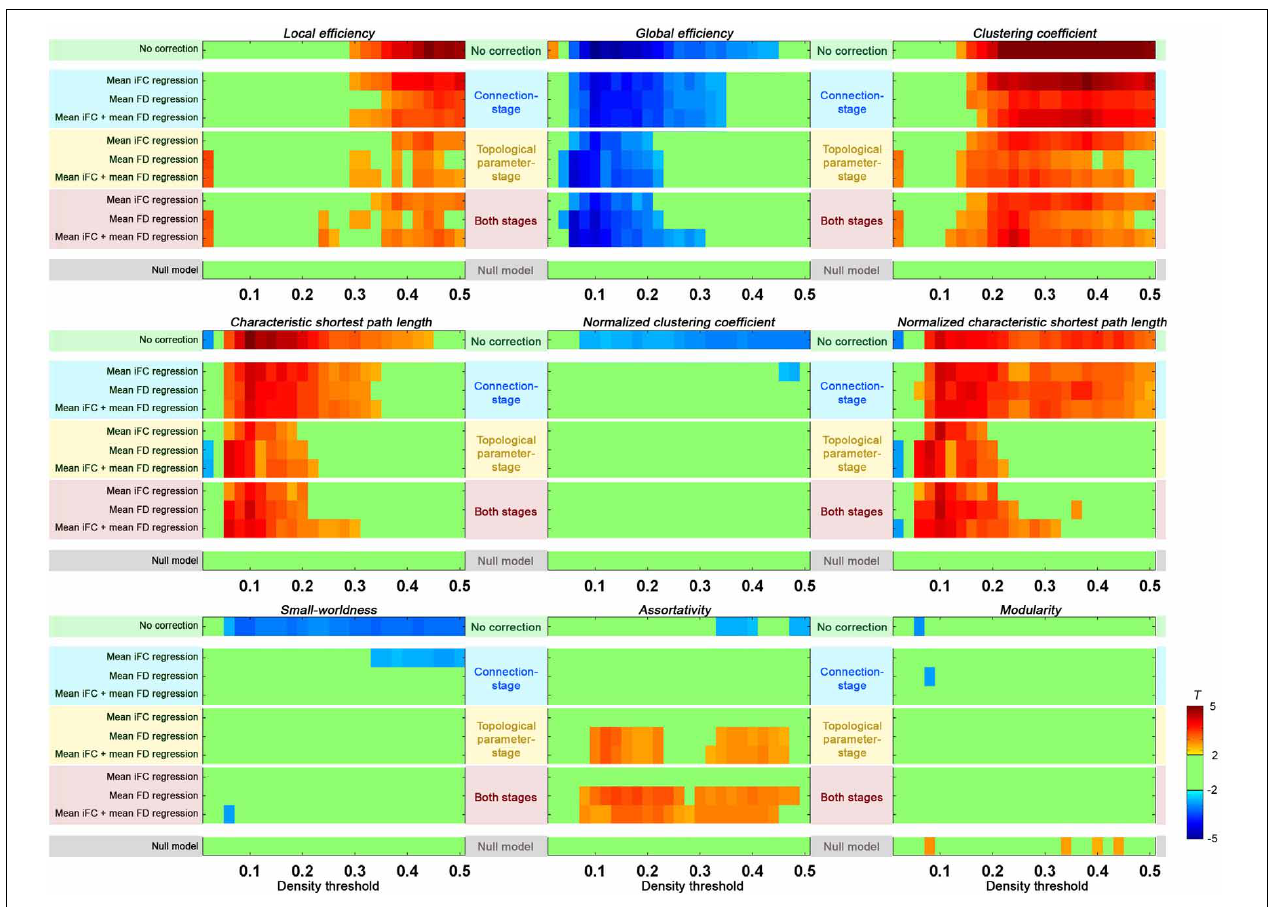
FIGURE 8 | Group-level correction in addressing residual head motion impact. Two-sample t -tests were performed on each of the global topological properties between upper motion tercile ( n = 32) and lower motion tercile ( n = 32) of Cambridge females. The “null model” was defined by performing two-sample t -test between two “null” groups (mixing the motion terciles and equating for motion